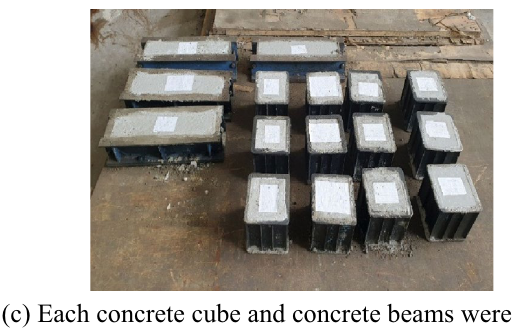
Fig. 5 Preparation process of shredded waste paper